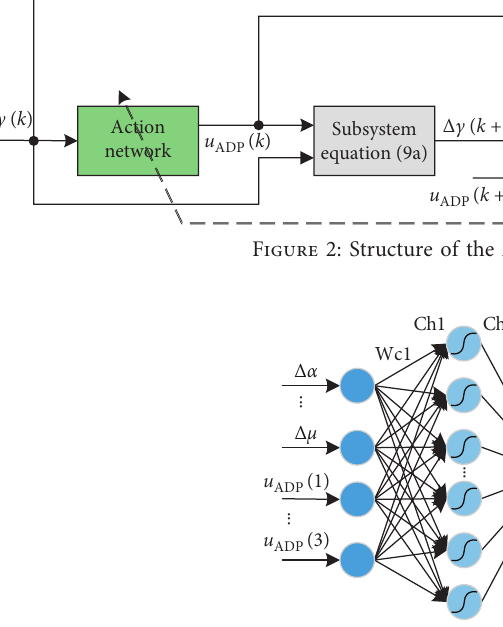
Figure 3: Structure of the critic